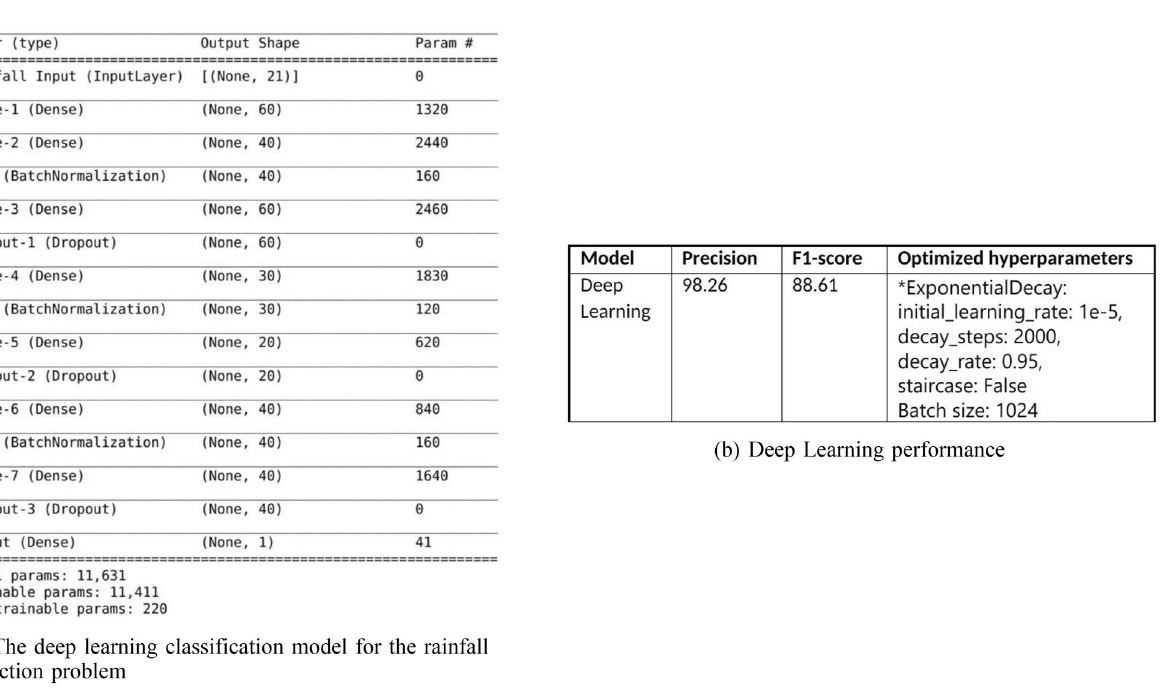
Figure 19. Deep learning model and